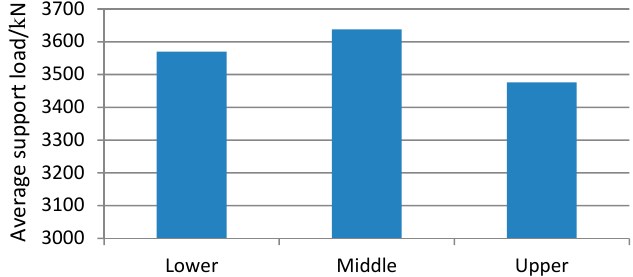
Figure 11. Behavior of the support load along the inclination direction.